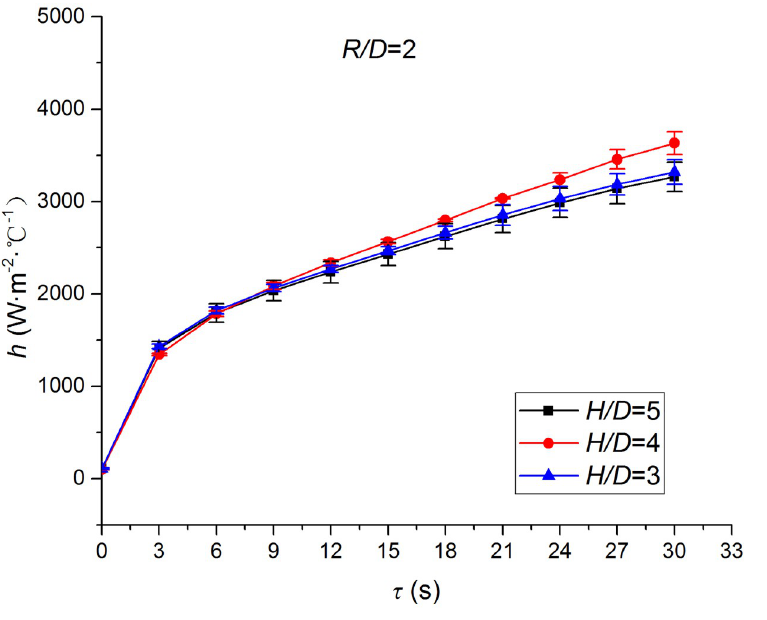
Fig 28. Convective heat transfer coefficient at R/D = 2.